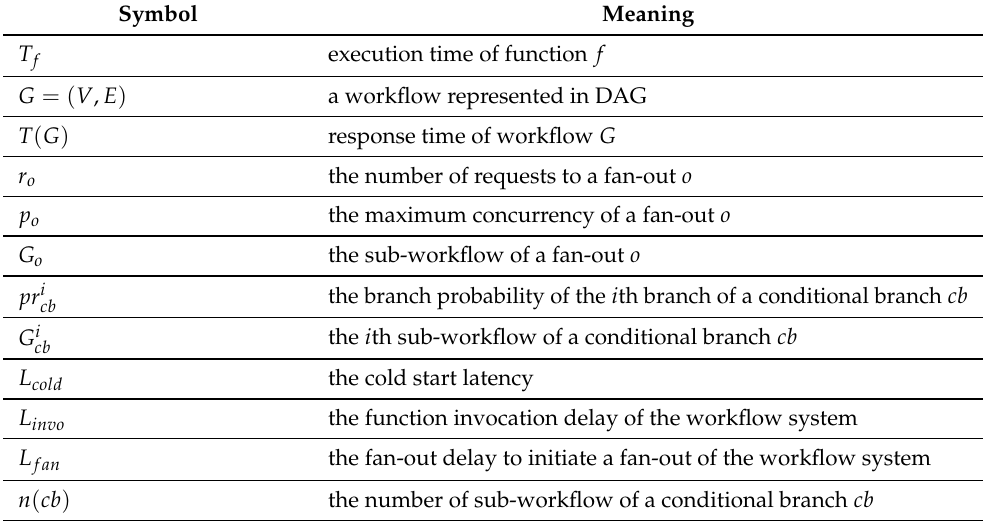
Table 1. Symbols used in this paper.